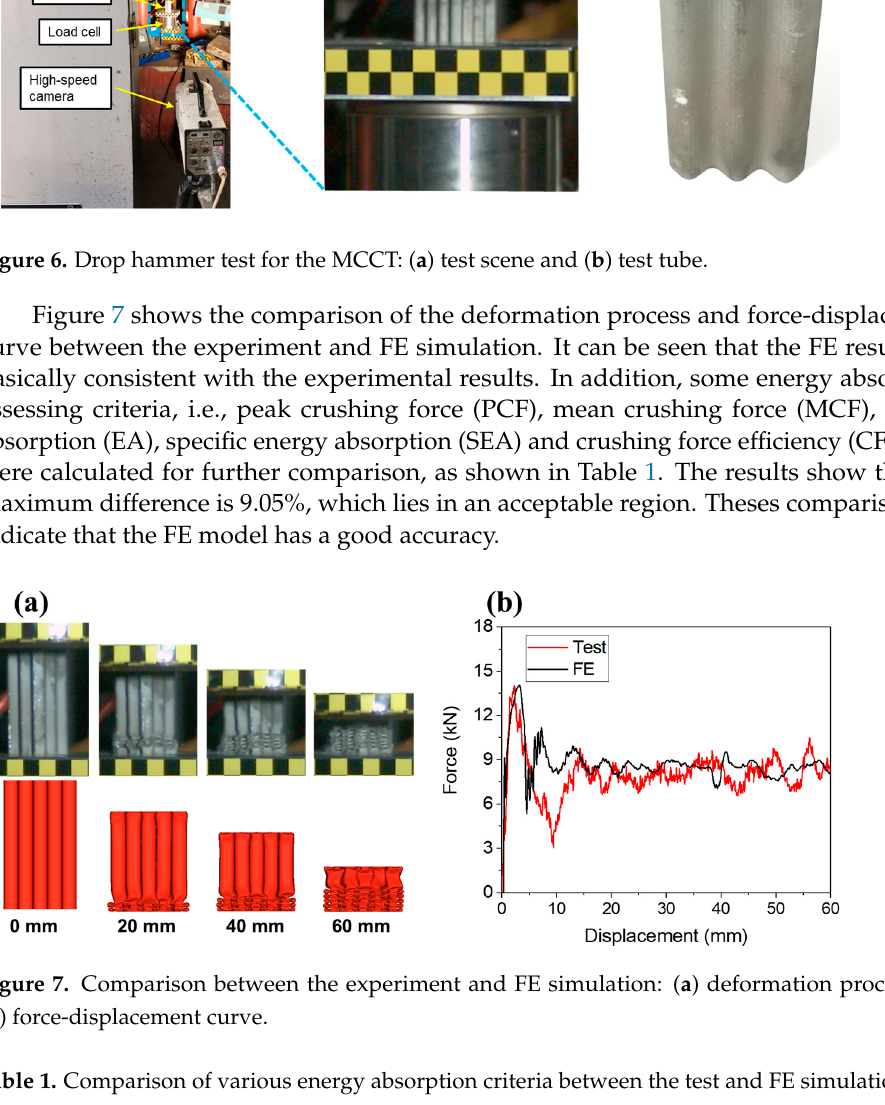
6 of 17 Figure 4. FE model of the MCCT under axial loading : ( a ) FE model and ( b ) stress-strain curve of the material aluminum alloy AA 6061O. Figure 5. MCF for different mesh sizes. 2.3. Validation of the FE Model